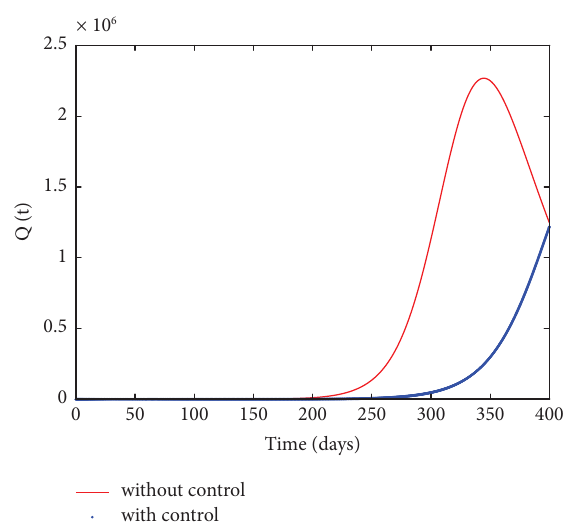
Figure 13: Behaviour of the quarantine individuals with and without the control.